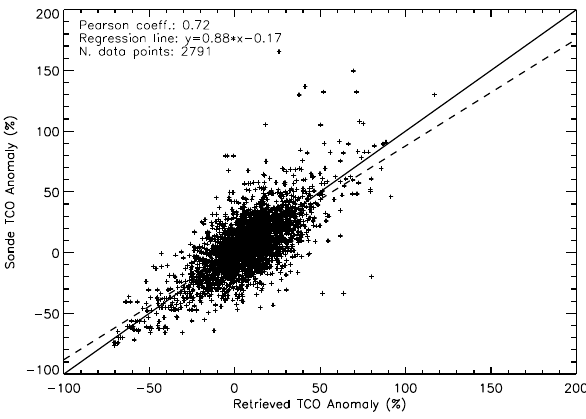
Fig. 7. Comparison between actual and estimated TCO anomaly.